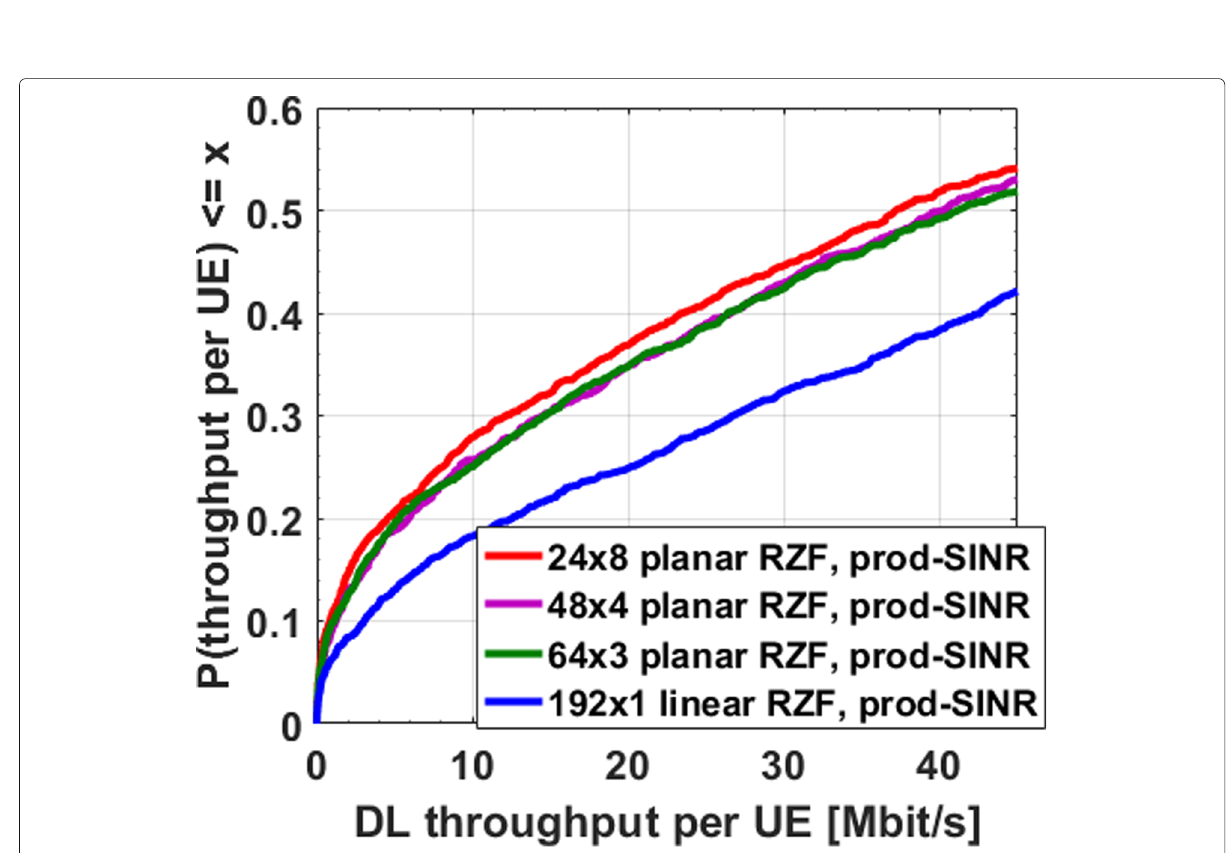
Fig. 13 DL throughput per UE between different antenna array configurations all containing 192